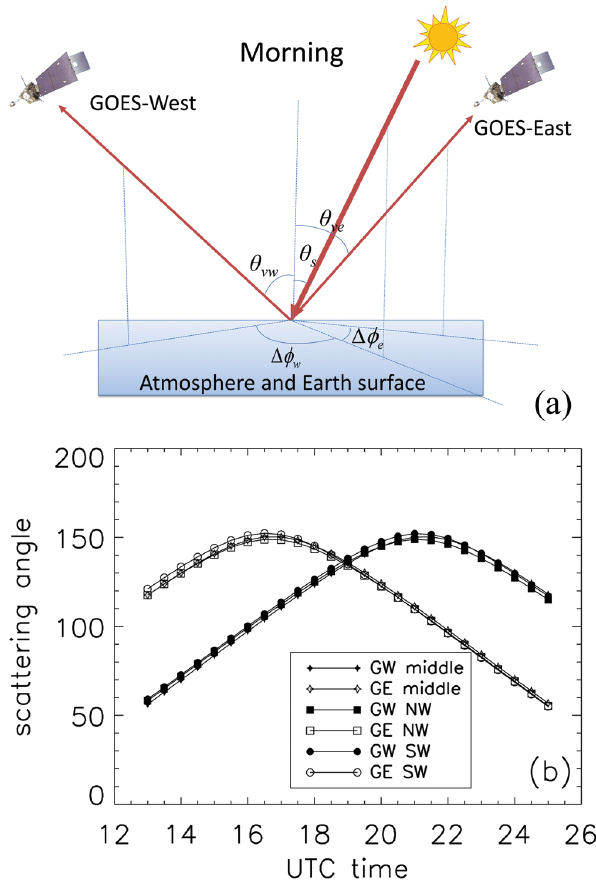
Fig. 1. (a) The scattering geometry of the Sun and the two GOES satellites in the morning for western US region. The angles in the figure are defined as following: θ s – solar zenith angle, θ vw – GOES- West view zenith angle, θ ve – GOES-East view zenith angle, 1φ w – relative azimuth angle between the Sun and GOES-West, 1φ e – relative azimuth angle between the Sun and GOES-East. (b) The scattering angle vs. UTC time of middle (37.5 ◦ N, 105 ◦ W), north- west (NW, 50 ◦ N, 125 ◦ W), southwest (SW; 25 ◦ N, 125 ◦ W) of the overlapping region for GOES-West (GW) and GOES-East (GE) on a selected day (19 June). The scattering angles do not vary much for the same satellite over different